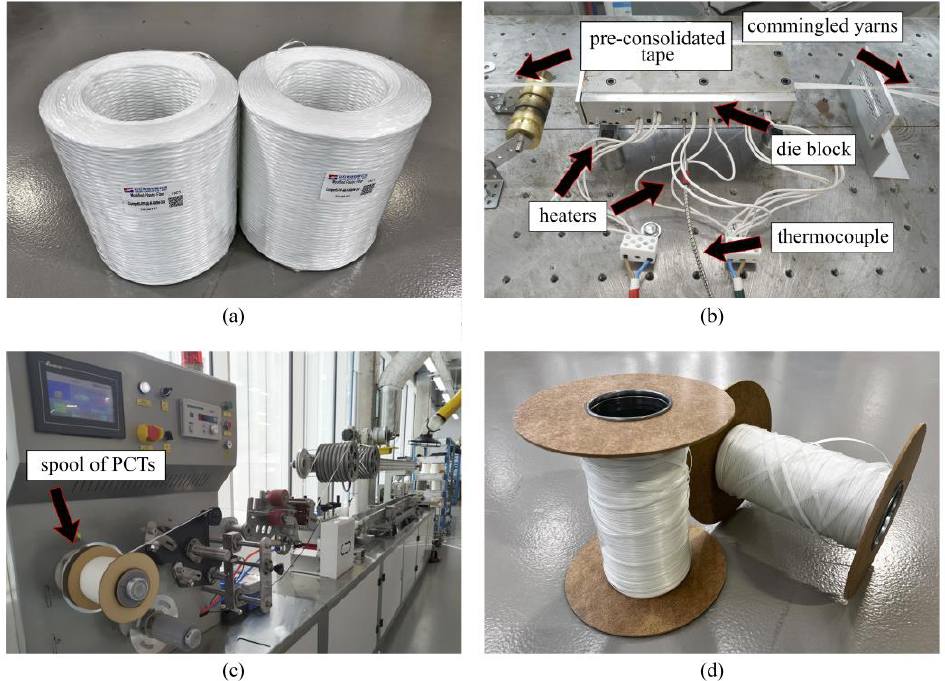
Figure 3. Inhouse fabrication of thermoplastic GF/PP PCTs: ( a ) source material—glass fiber/polypropylene (GF/PP) commingled yarns (Jushi Holdings Inc., USA); ( b ) heated die block with corrugated cavity, used for production of PCTs; ( c ) plastron FLD 35 extrusion machine; ( d ) inhouse-made PCTs.